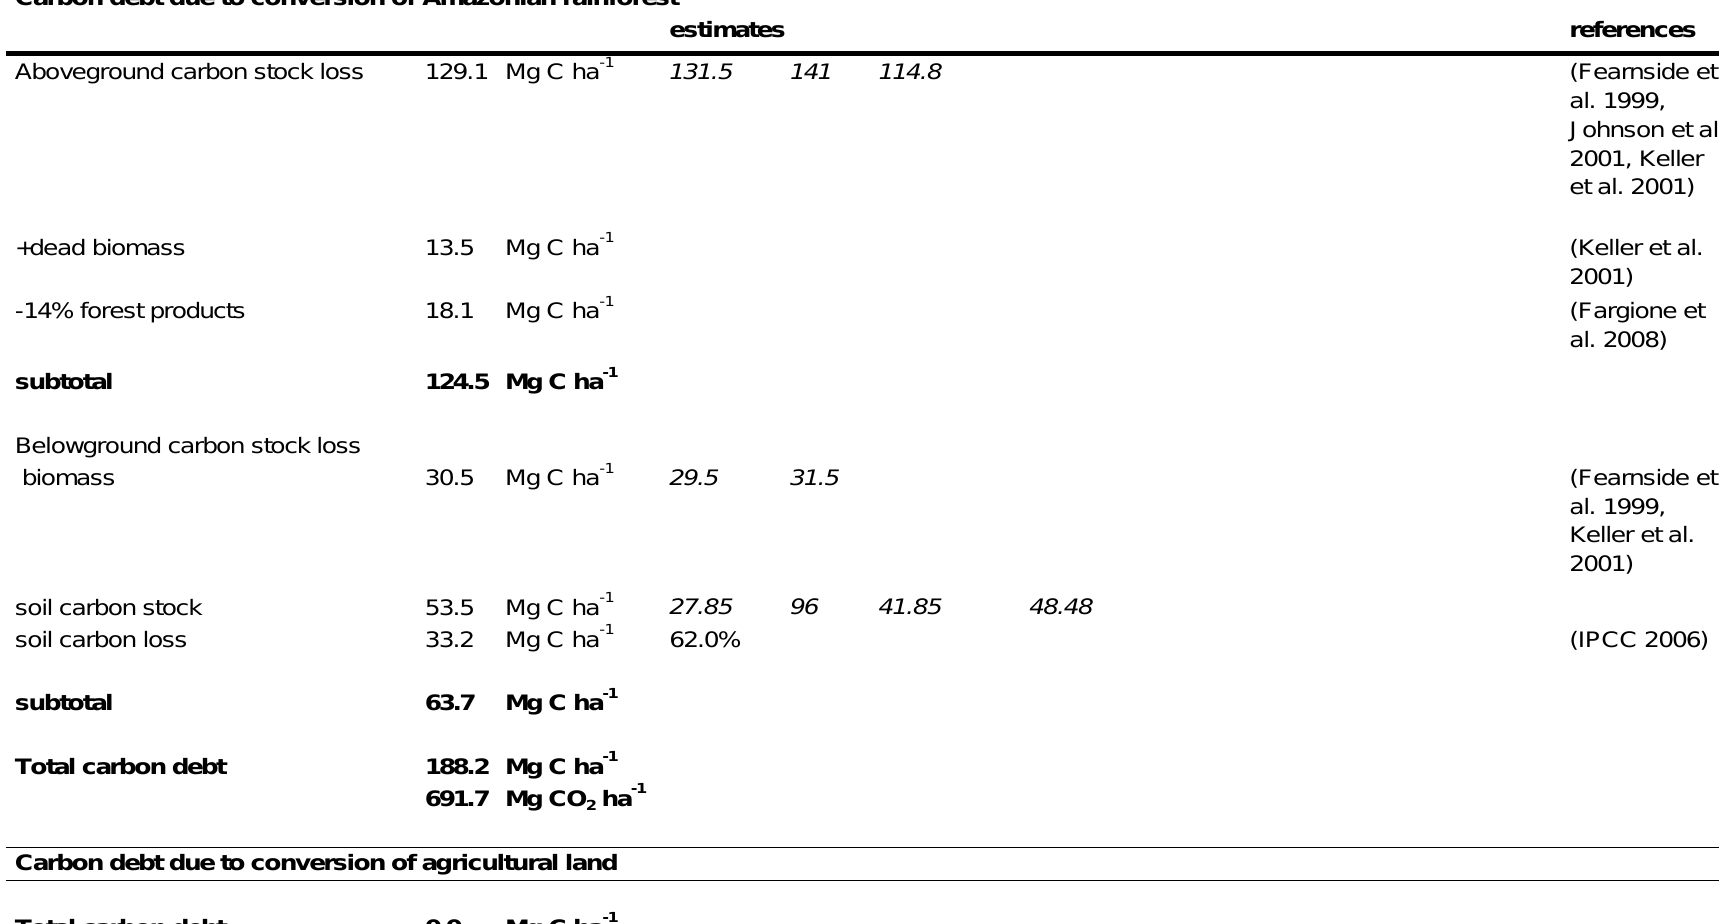
Table A6.3. Carbon debt calculation of Santarem, Brazil case Carbon debt due to conversion of Amazonian